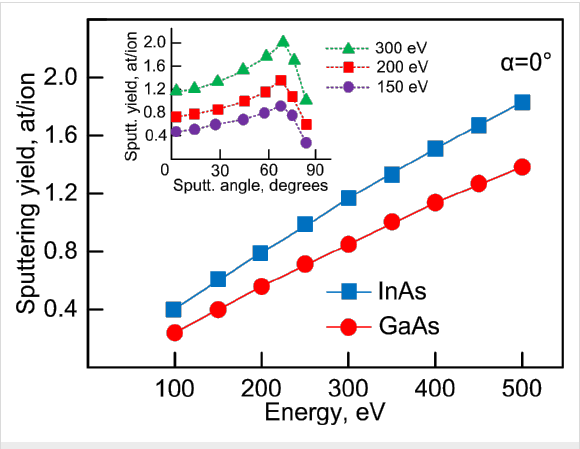
Figure 1: Energy dependence and angular dependence of sputtering